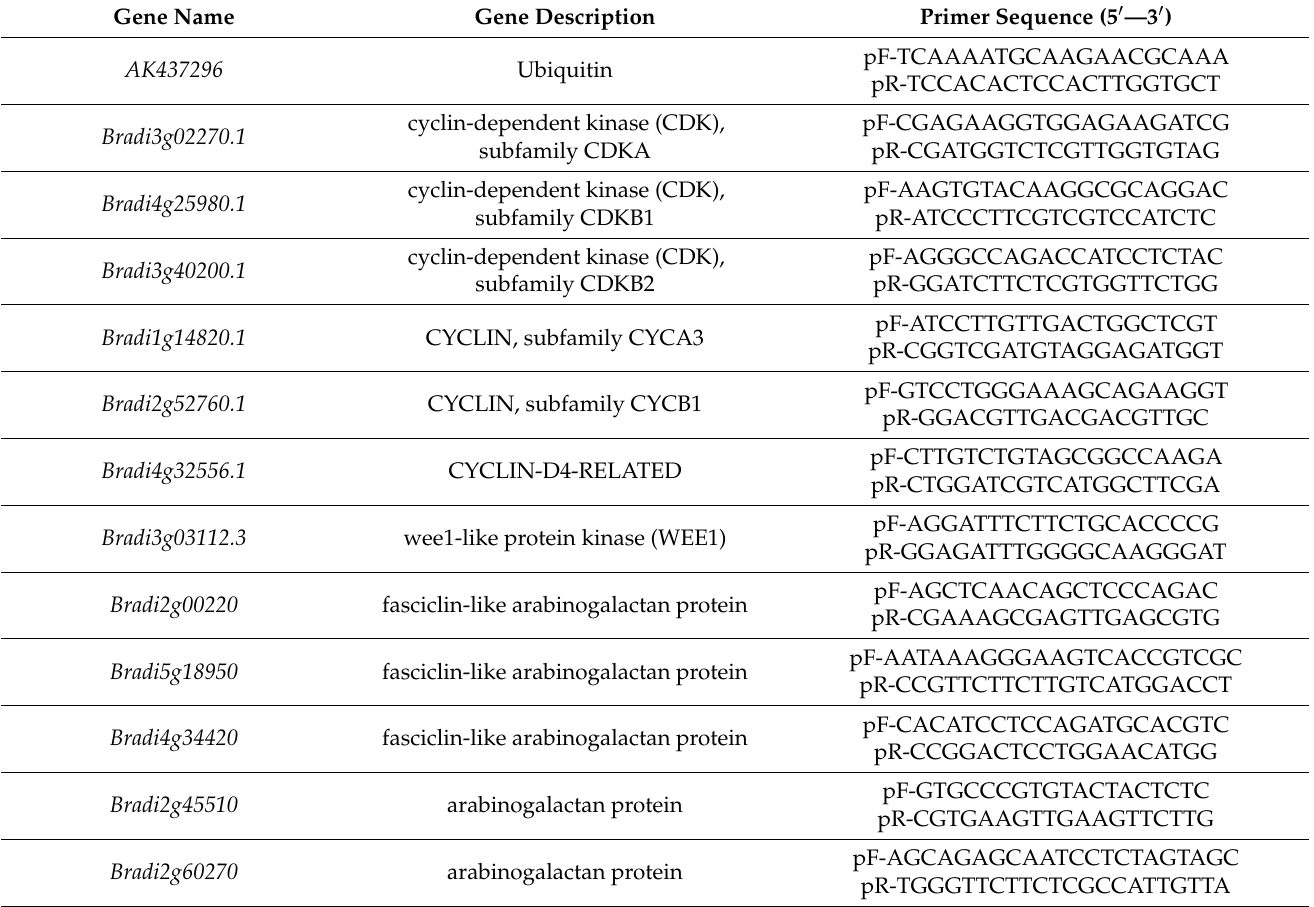
Table 1. The oligonucleotide primers that were used in RT-qPCR